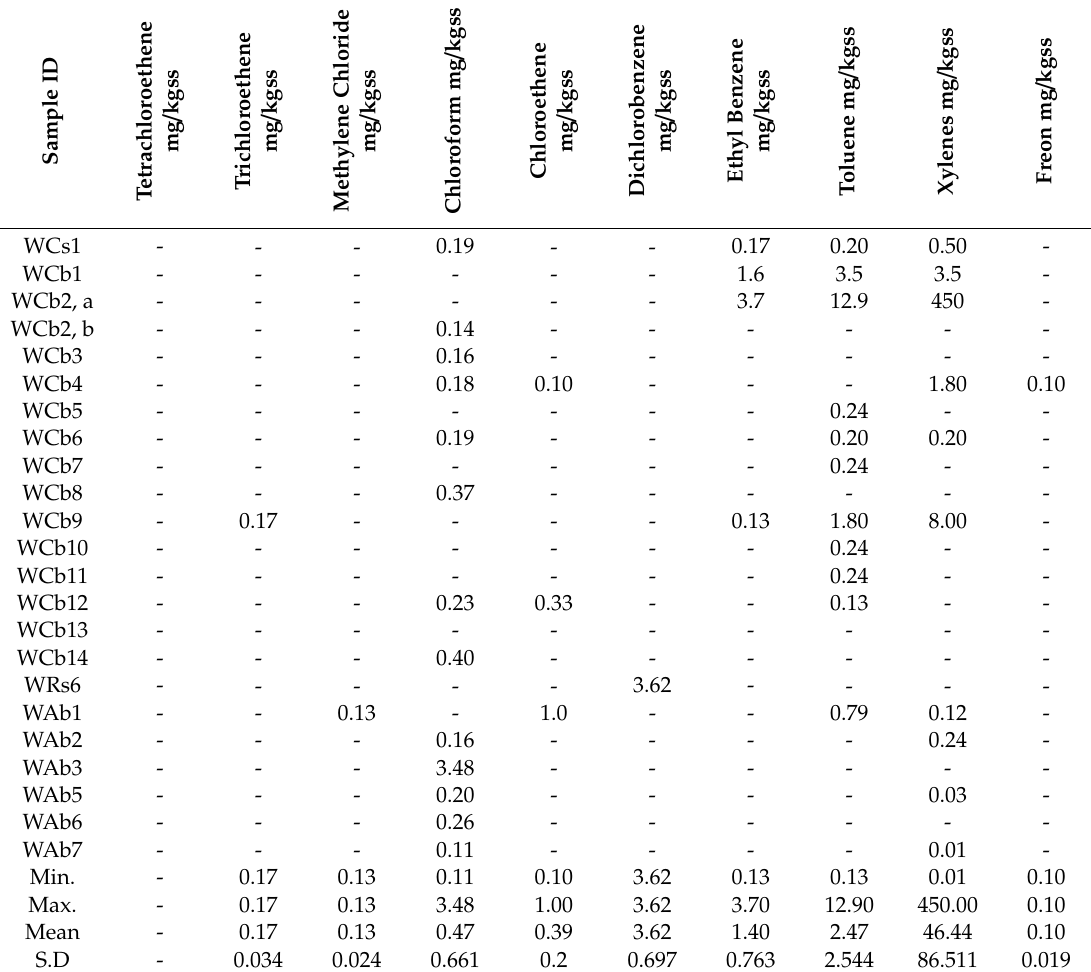
Table 6. LNPL concentrations in water